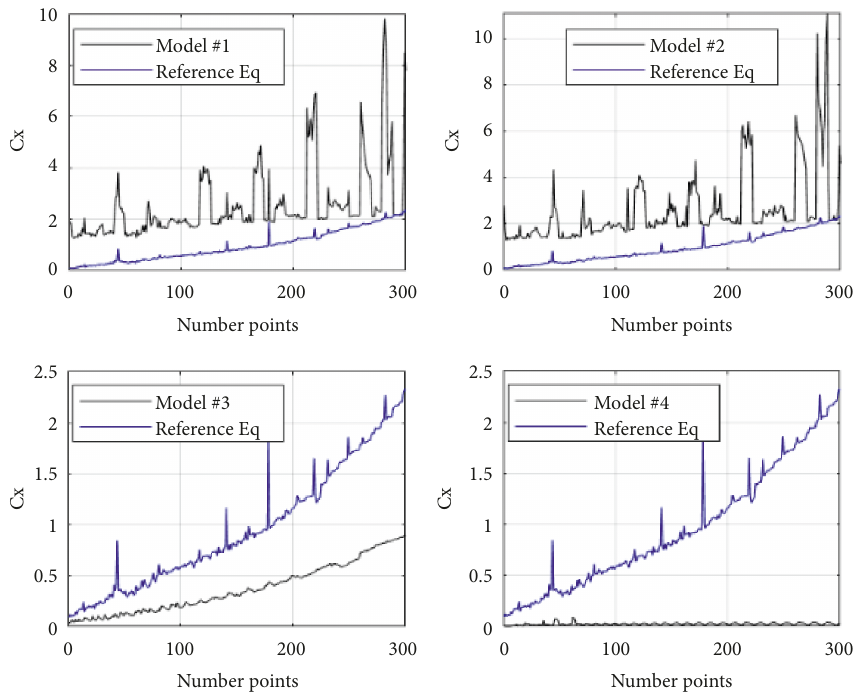
Figure 8: Plots of complexity Cx for the models of Table 1 in Section 3.